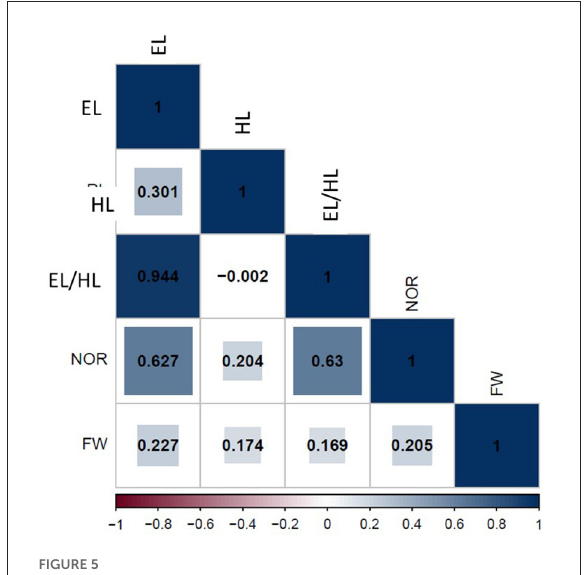
FIGURE5 Phenotypic correlation among all traits scored under 50% seawater